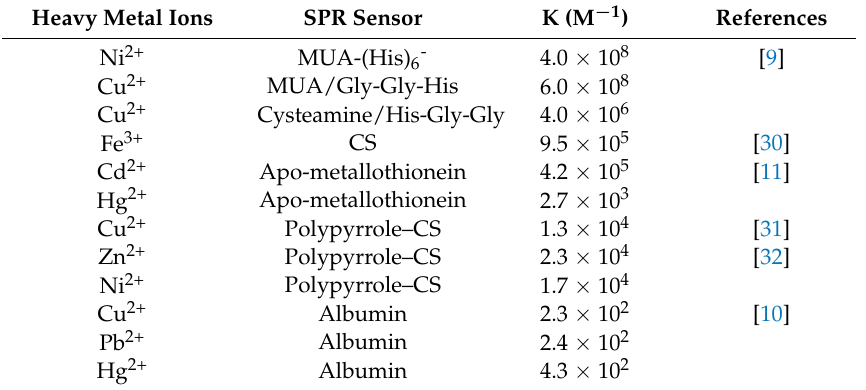
Table 1. Langmuir affinity binding constant, K, for various heavy metal ions using the SPR